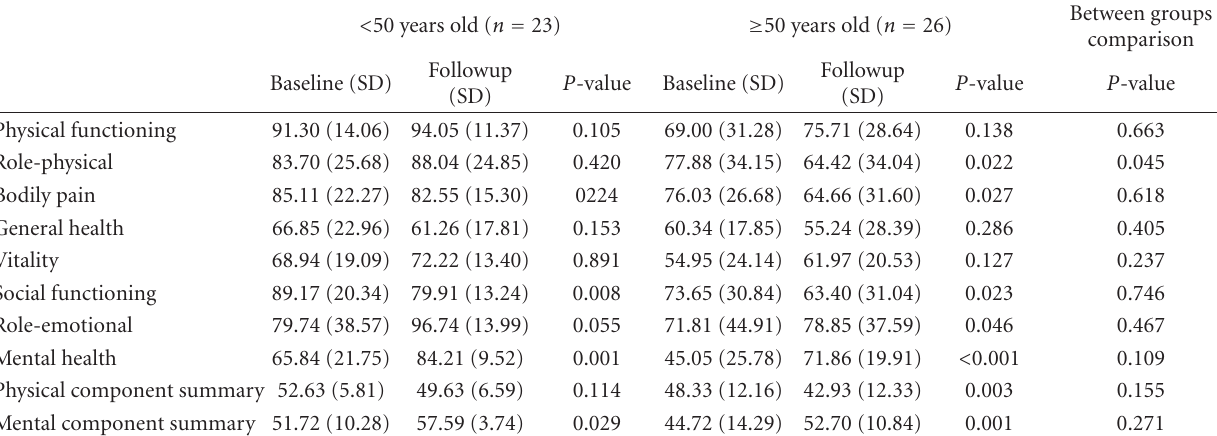
Table 5: The HRQoL scores at the first and third year post-treatment based on the age groups. < 50 years old ( n = 23)